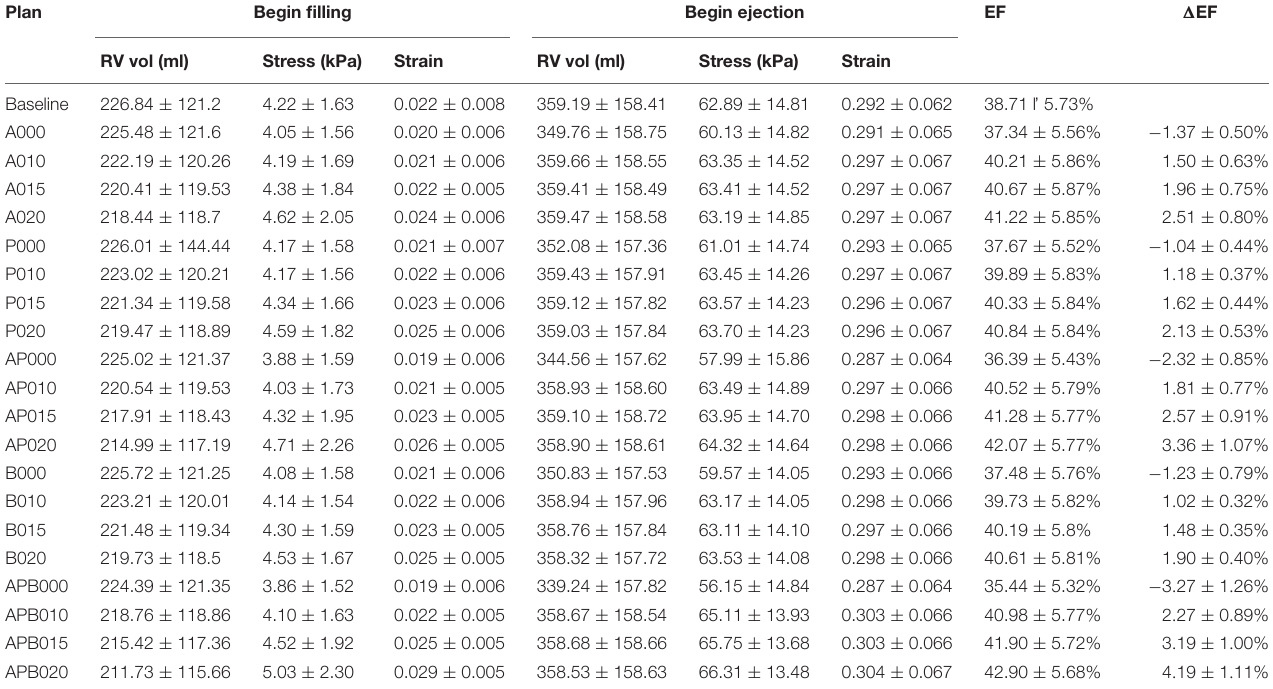
TABLE 6 | Mean ± SD RV ejection fraction and wall stress/strain data of seven TOF patients from 140 RV/LV models with active or passive band(s) and seven models without band.